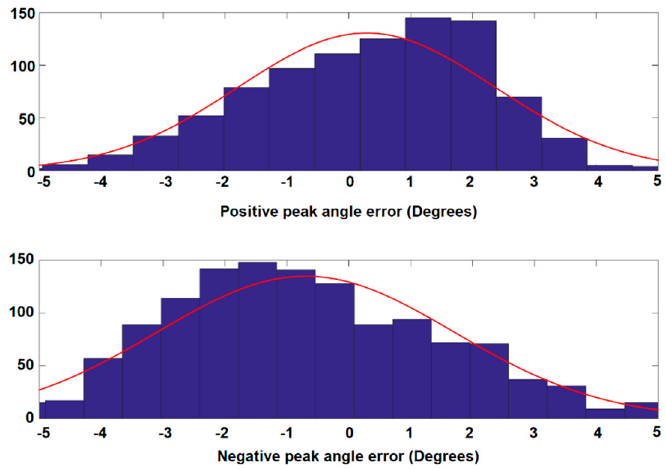
Figure 8. Histograms of positive and negative peak angle errors.